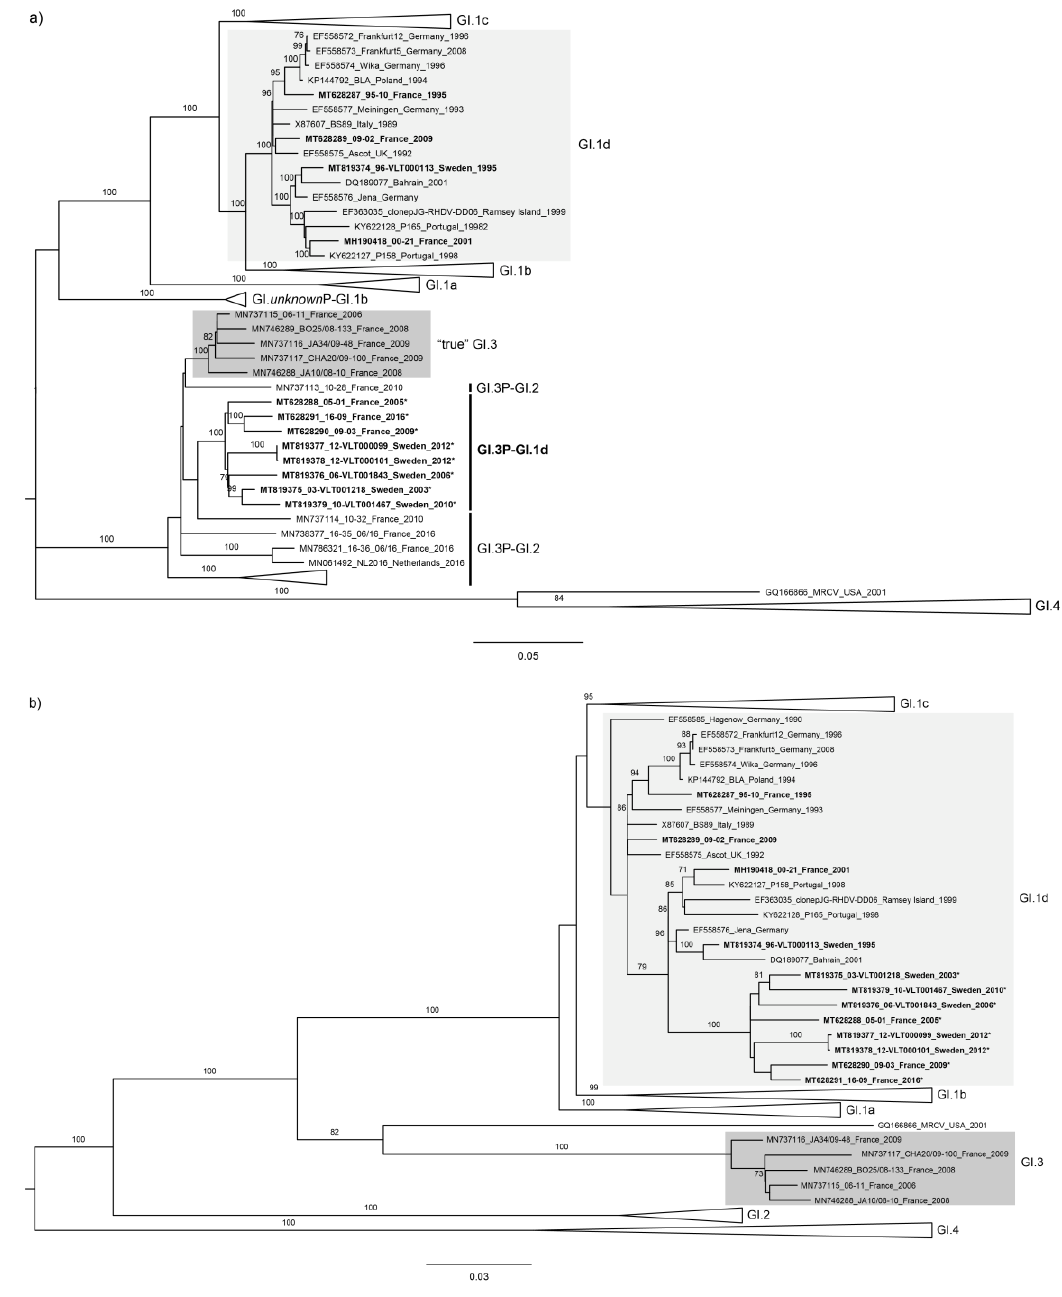
Figure 1. Maximum likelihood (ML) phylogenetic trees for ( a ) the nonstructural genes ( n = 237 sequences; nucleotides 1–5295; nucleotide substitution model GTR + G + Γ 4) and ( b ) the structural genes ( n = 237 sequences; nucleotides 5296–7369; nucleotide substitution model GTR + G + Γ 4). Horizontal branch lengths are drawn to scale of nucleotide substitutions per site, and the trees are midpoint-rooted. The percentage of trees in which the associated taxa clustered together was determined from 1000 bootstrap replicates and is shown next to the branches (only bootstrap values ≥ 70 are shown). Sequences obtained in this study are shown in bold. Recombinant strains are marked with *. GenBank accession numbers of the sequences that appear in the collapsed branches are listed in the supplementary information (Supplementary Table S1).